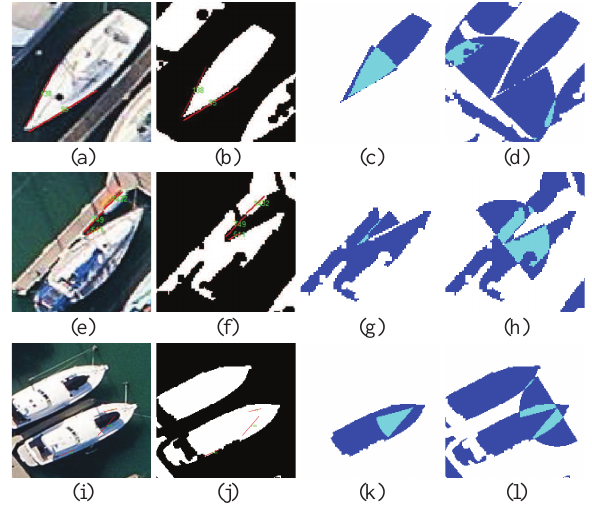
Figure 4: Examples of ship head candidate validation. (a), (e) and (i) show the partial regions of a test remote sensing image containing ship candidates. (b), (f) and (j) show the segmentation binary results of (a), (e) and (i), respectively. In (c), (g) and (k), the cyan regions are the overlaps of their section mask regions M S and the connected regions containing ship candidates, respectively. In (d), (h) and (l), the cyan regions are the overlaps of their semi-circle mask regions M C and their segmentation images, respectively.